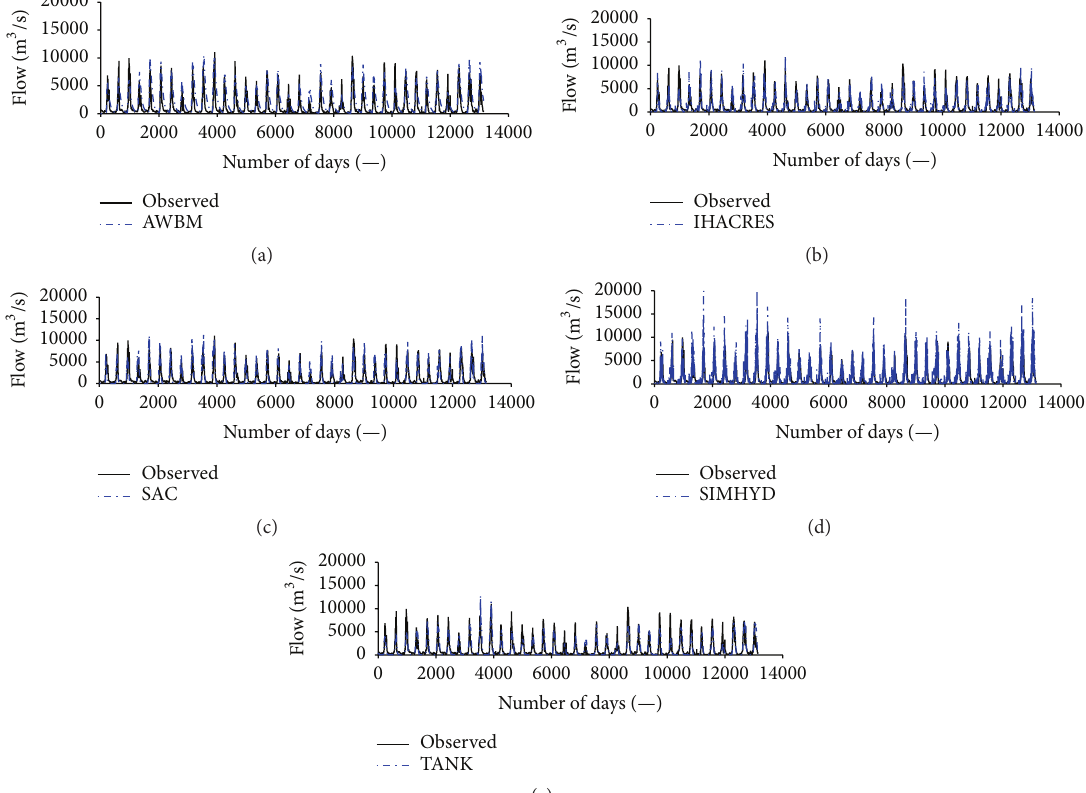
Figure 5: Observed and modeled daily flows from (a) AWBM, (b) IHACRES, (c) SAC, (d) SIMHYD, and (e) TANK. In the horizontal axis, the calibration period (from 1/1/1965 to 31/12/1990) covers the number of days in the range of 1–9496. Similarly, the validation period (from 1/1/1991 to 31/12/2000) is from 9497–13149 days.